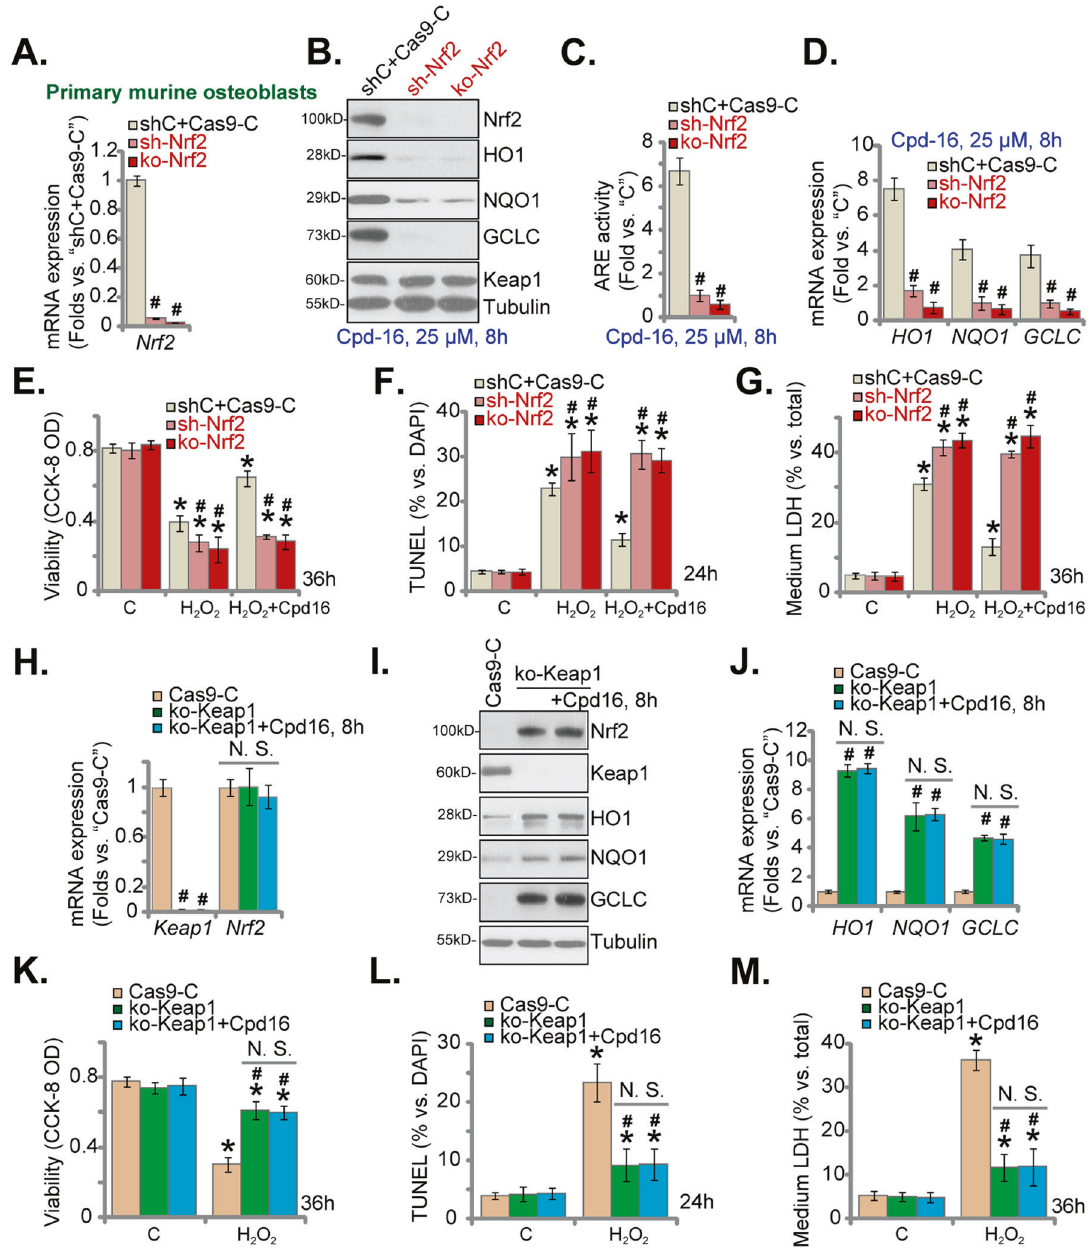
Fig. 6 Nrf2 activation is indispensable for Cpd16-mediated osteoblast cytoprotection. Nrf2 mRNA expression in the listed primary murine osteoblasts was measured ( A ); the osteoblasts were treated with Cpd16, and listed proteins ( B ), ARE activity ( C ), and listed mRNAs ( D ) were measured; the murine osteoblasts were pretreated with Cpd16 (25 μ M) for 2 h, followed by H 2 O 2 (400 μ M) stimulation, with cell viability, apoptosis and necrosis tested by CCK-8 ( E ), TUNEL-nuclei staining ( F ), and LDH releasing G assays, respectively. Keap1 - Nrf2 mRNA expression in the ko-Keap1 or Cas9-C murine osteoblasts was measured ( H ); the ko-Keap1 murine osteoblasts were also treated with or without Cpd16 (25 μ M), expression of listed proteins and mRNAs ( I , J ) was measured; the ko-Keap1 osteoblasts were pretreated with Cpd16 (25 μ M) for 2 h, followed by H 2 O 2 (400 μ M) stimulation; cell viability, apoptosis, and necrosis were measured by CCK-8 ( K ), TUNEL-nuclei ( L ), and LDH releasing M assays, respectively. * P < 0.05 versus “ C ” cells. # P < 0.05 versus “ shC + Cas9-C ” / “ Cas9-C ” osteoblasts. “ N.S. ” stands for the non-statistical difference ( P > 0.05). dramatic Keap1-Nrf2 disassociation and direct Nrf2 cascade and enhanced ARE reporter activity as well as transcription of Nrf2 activation. Indeed, we found that Keap1 Cys151S mutation response genes ( HO1 , GCLC , and NQO1 ) in cultured osteoblasts/ osteoblastic cells. Signi fi cantly, Cpd16 ameliorated oxidative injury in H 2 O 2 -stimulated osteoblasts. We found that Cpd16-induced Nrf2 activation and osteoblasts protection against H 2 O 2 were stronger than other known Nrf2 activators (SFH, 4-OI, and TBHQ). One possibility is that Cpd16 could induce Keap1 cysteine (151) alkylatation, leading to Cell Death Discovery (2022)